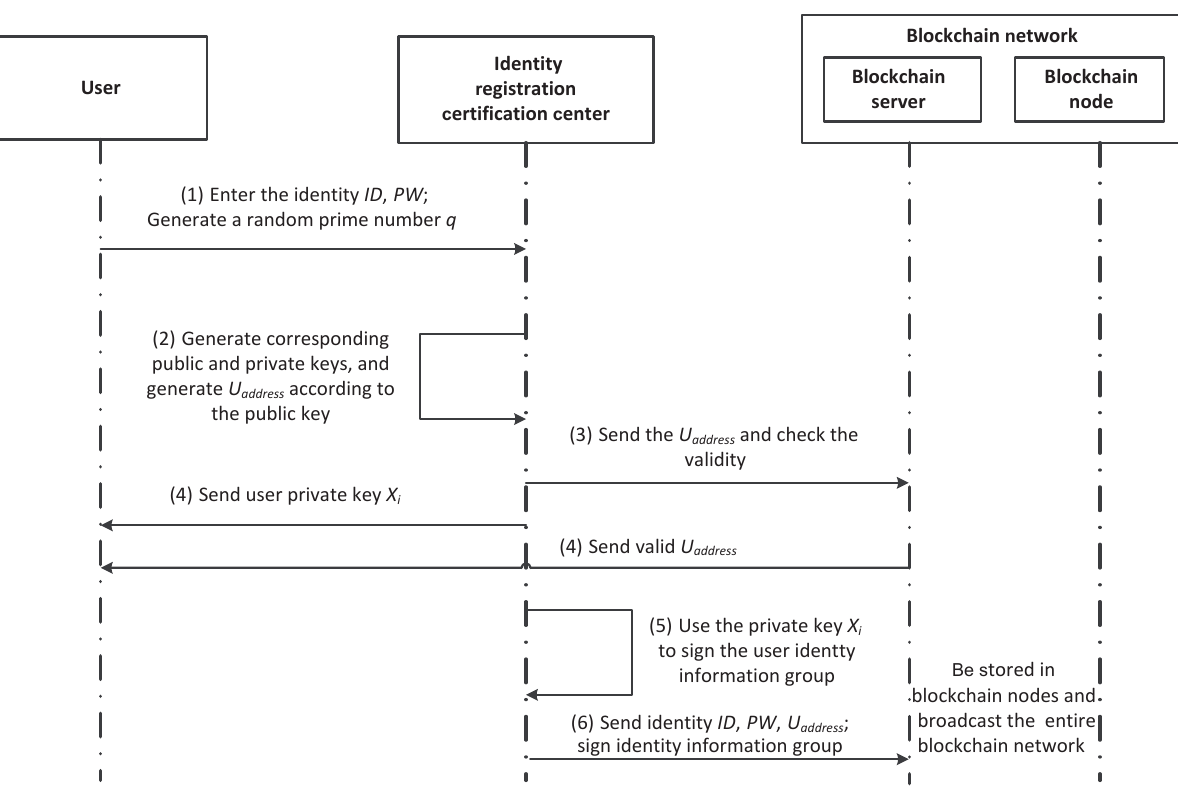
Fig. 3 Workflow of the identity registration